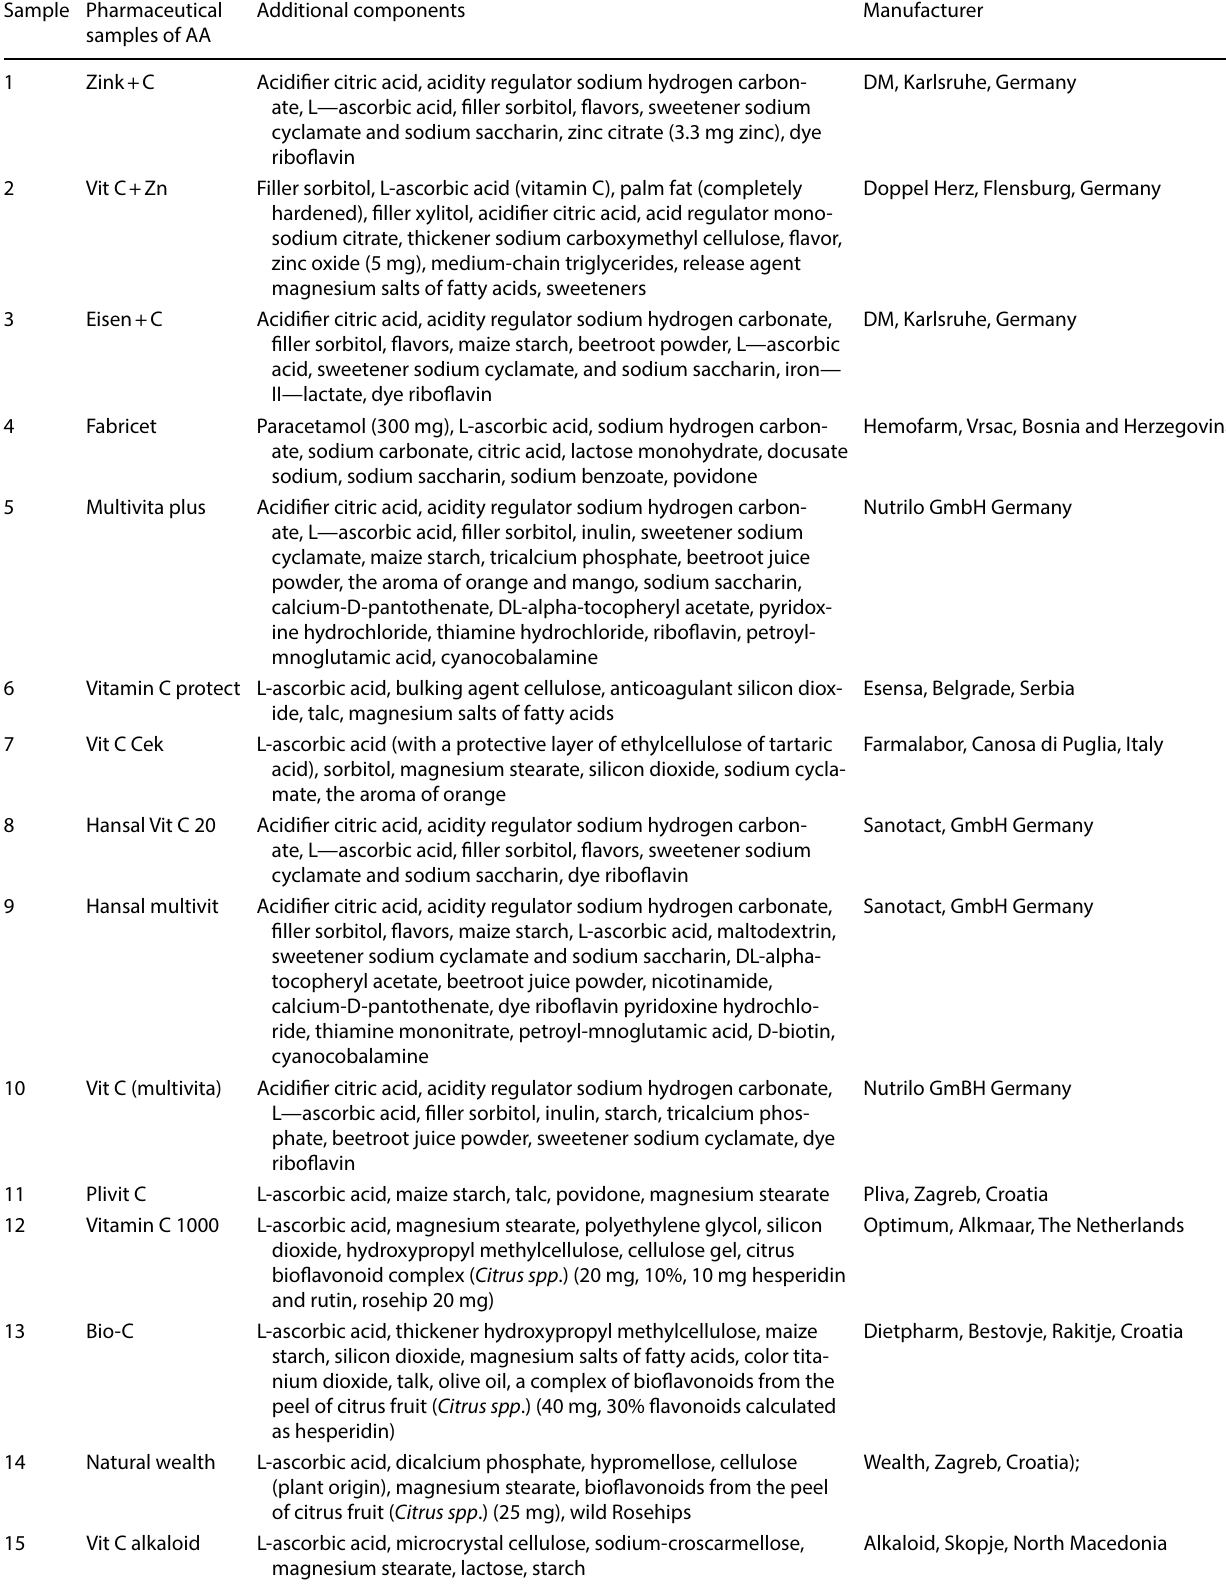
Table 1 Commercially available pharmaceutical samples that were analyzed Sample Pharmaceutical samples of